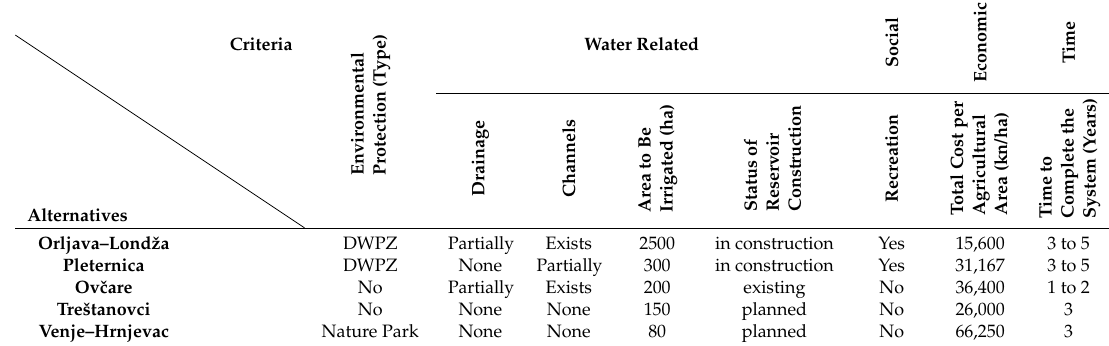
Table 2. Characteristics of all alternatives sorted by selected criteria